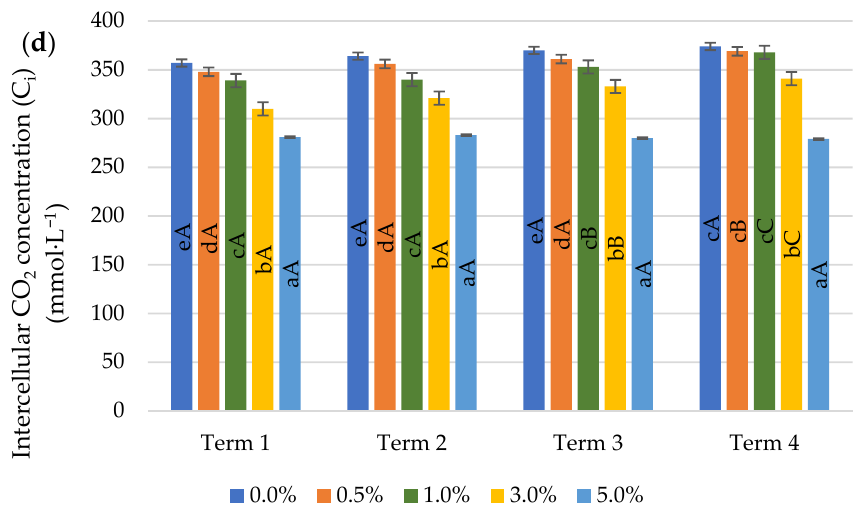
Figure 5. Effect of quercetin derivative concentrations and terms of measurement on gas exchange parameters: ( a ) stomatal conductance (g s ); ( b ) net photosynthesis rate (P N ); ( c ) transpiration rate (E) and ( d ) intercellular CO 2 concentration (C i ). (Term 1—first day after the first treatment, Term 2—seventh days after the first treatment, Term 3—first day after the second treatment, Term 4—seventh days after the second treatment). Capital letters indicate significant differences between the means at measurement terms for each quercetin derivative concentrations, lowercase letters indicate significant differences between the means at respective measurement terms according to ANOVA (followed by Tukey’s HSD test, p = 0.05).